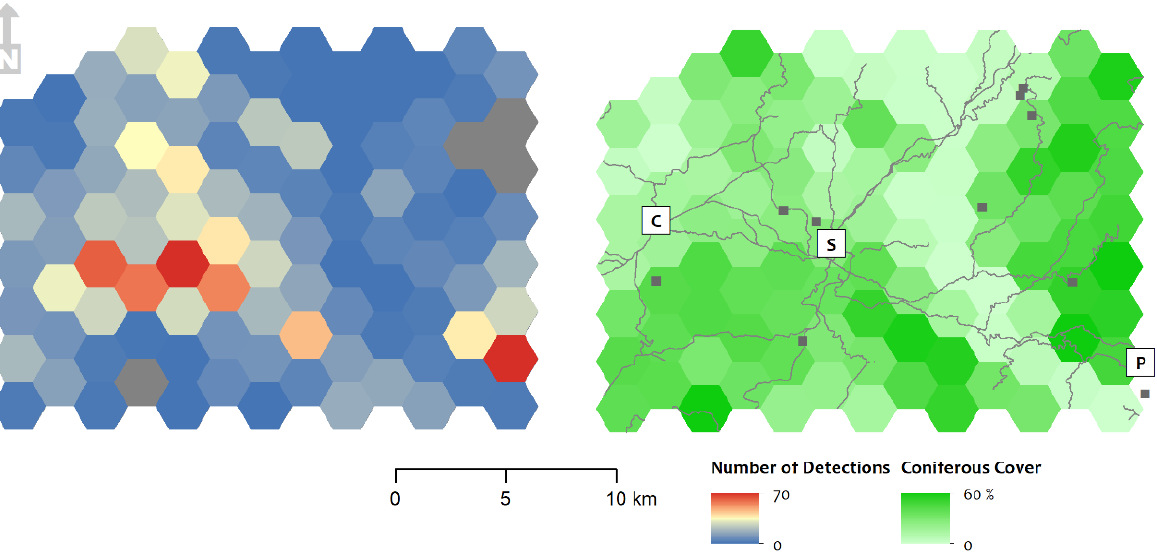
Figure 10. The number of detections in the Sentinel-2 model (declining trees), at a regional level, calculated for a reference tessellated hex grid for the 2020 season. Percent cover of conifers (mostly maritime pine) is represented as well as main roads, major population centers, and sawmills/wood depots (dark squares). S: Sertã; P: Proença-a-Nova; C: Cernache do Bonjardim (main urban centers).